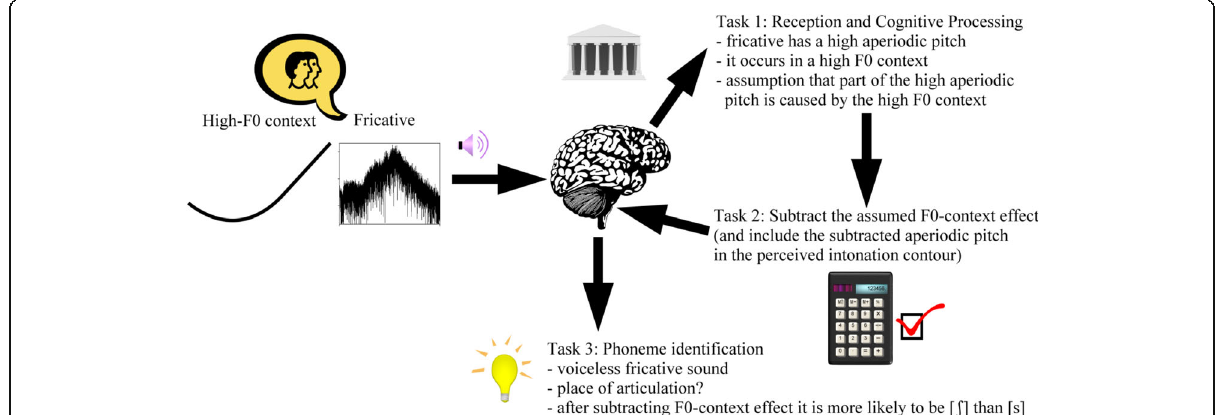
Fig. 2 Schematic illustration of the “ subtraction ” idea and the corresponding top-down cognitive speech processing mechanism that underlie the hypotheses 2 (a) and (b) and 3 of the present study. See, e.g. Ohala and Feder [37], Harrington et al. [39], and Kleber et al. [40] for related work and findings on the perceptual compensation of